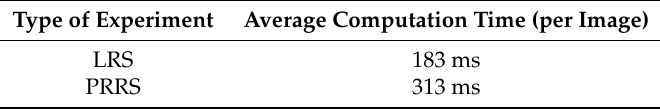
Table 7. Average computation time for one